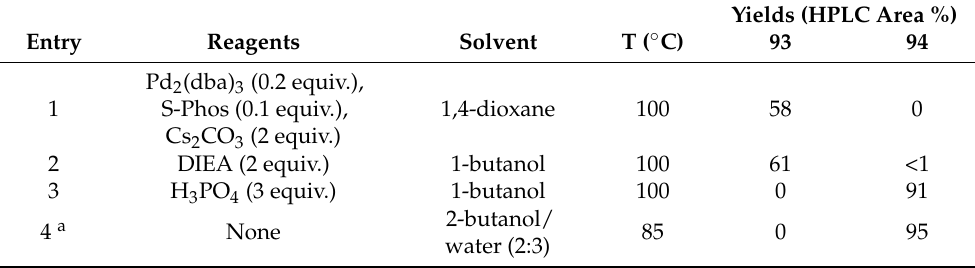
Yields (HPLC Yields (HPLC Area Area %)